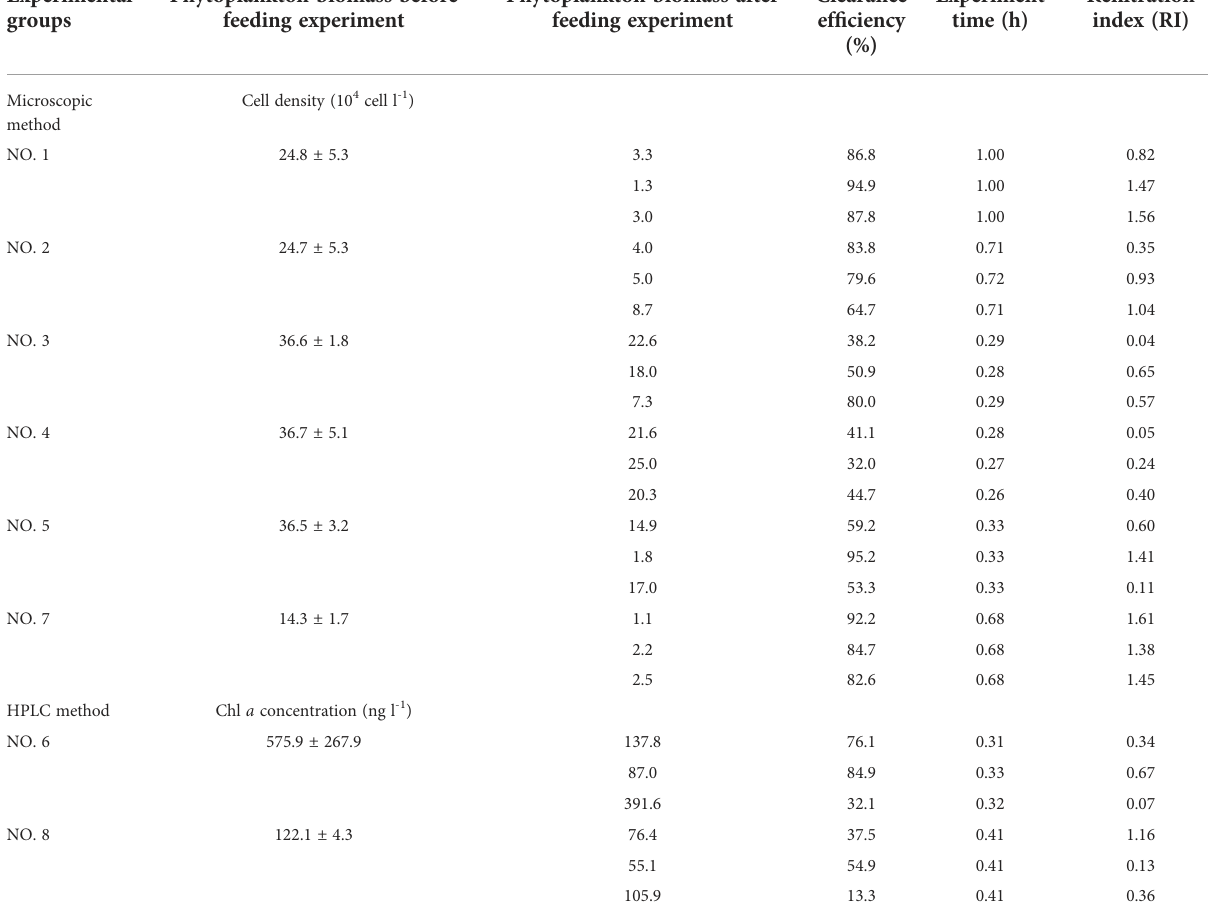
TABLE 1 Experimental design and total phytoplankton biomass in each experimental group (n=3 mussels for each group). Experimental